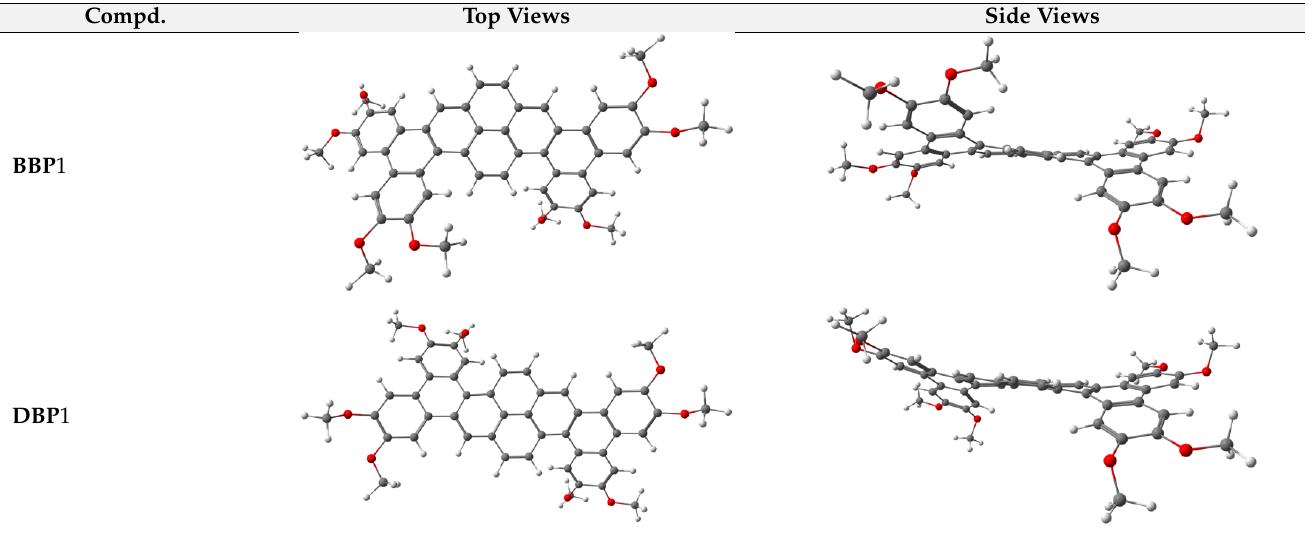
Table 3. Ball and stick model of optimized molecular structures of BBP 1 and DBP 1. Red: oxygen; dark gray: carbon; light gray: hydrogen.